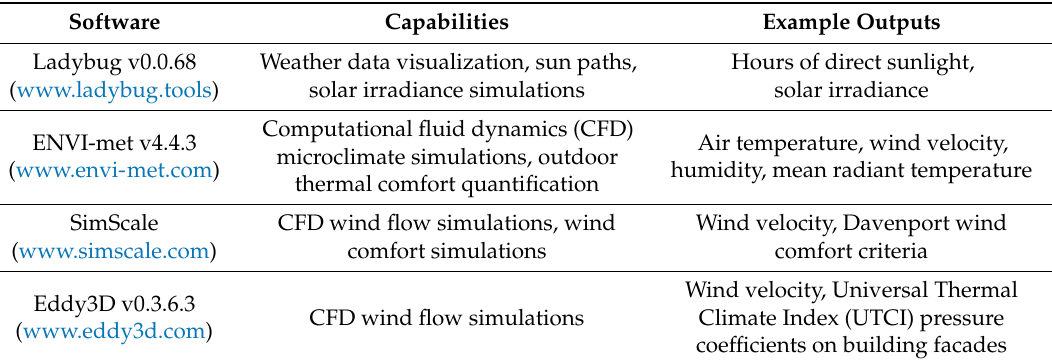
Table 1. Summary of the software discussed in this paper and their